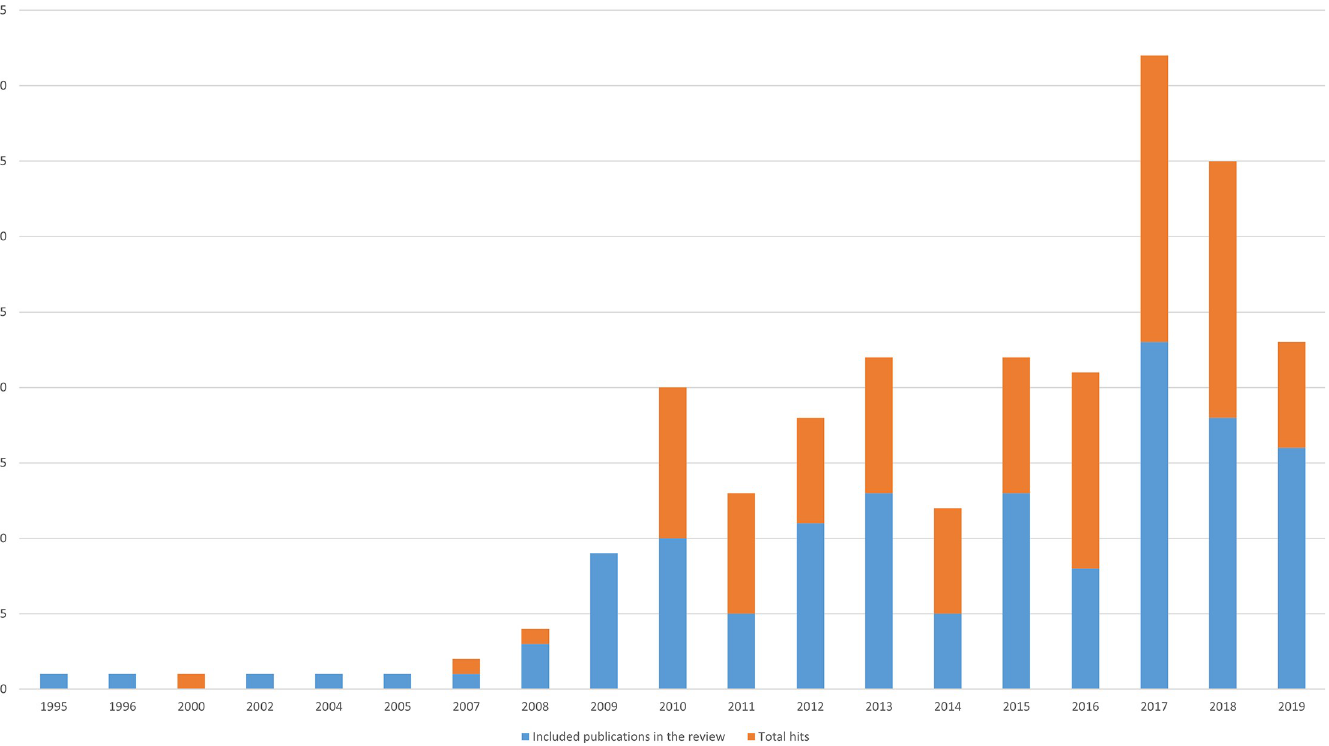
Fig 2. Number of publications using the term foodscape in the corpus of publications included in the review. 2019 includes from January to June.